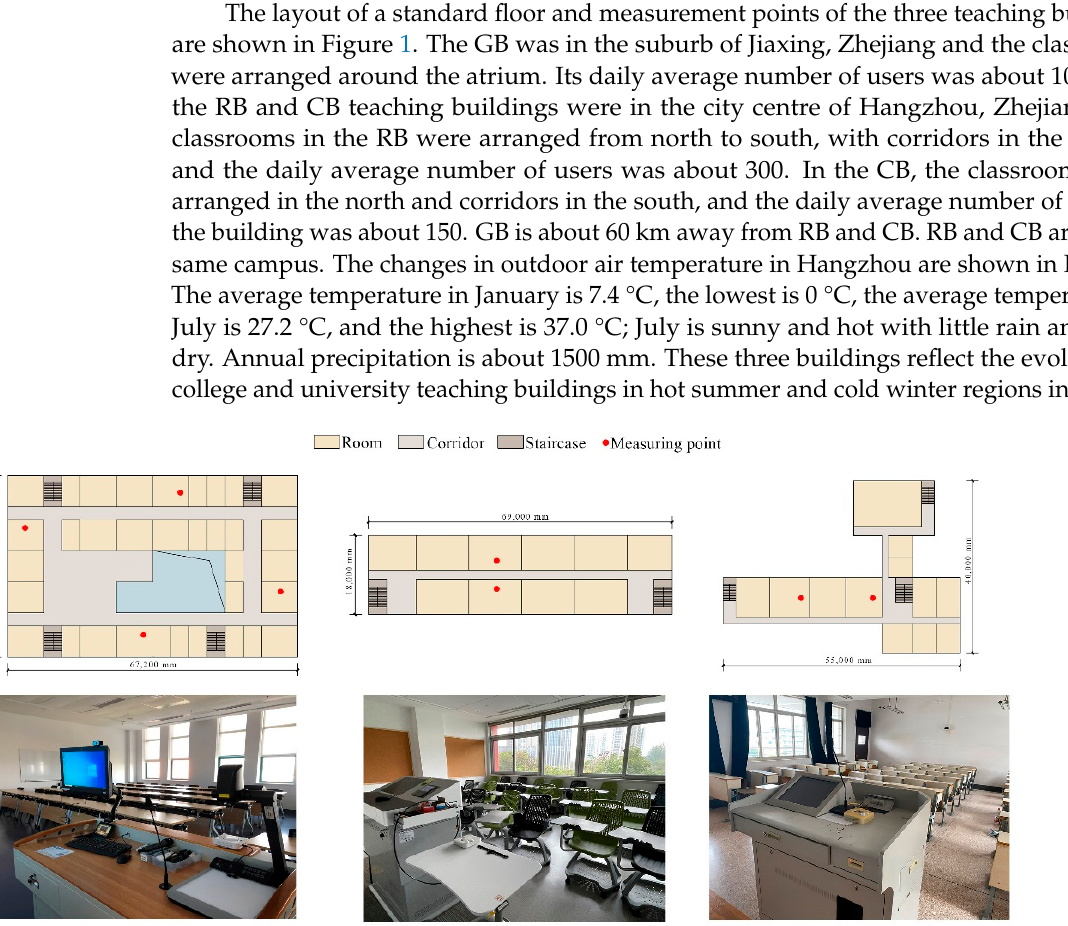
Figure 2. Changes in outdoor air temperature in Hangzhou in 2020. 2.2. Data Collection 2.2.1. Indoor Environmental Measurements This study was approved by the ethics committee of Hangzhou Integrative Medicine Hospital. As the classrooms were not used in the summer, indoor environmental meas- urements were taken during the transition season and winter. The transition season test time was from October to November 2020, and the winter test time was from December 2020 to January 2021. The IEQ generally includes measures of the thermal, light, air qual- ity, and acoustic environment [11–14]. Considering the required parameters and instru- ment availability, the indoor environment test parameters in this study included air tem- perature, relative humidity, PM 2.5 concentration, CO 2 concentration, desktop illuminance, and sound pressure level. The measurement plan of the indoor environment is shown in Table 2. A self-devel- oped machine was used, which was placed in the centre of the classroom to record the air temperature, relative humidity, CO 2 concentration, PM 2.5 concentration, and sound pres- sure level every 5 minutes. The single-chip computer NUC131LD2AE was used as the control core of the whole system, as shown in Figure 3. The sensors used in the machine and their accuracies are shown in Table 3. Considering the different orientations and room sizes, four classrooms were selected in the GB, four in the RB, and two in the CB. Since desktop illuminance was greatly affected by human activities and natural lighting, this